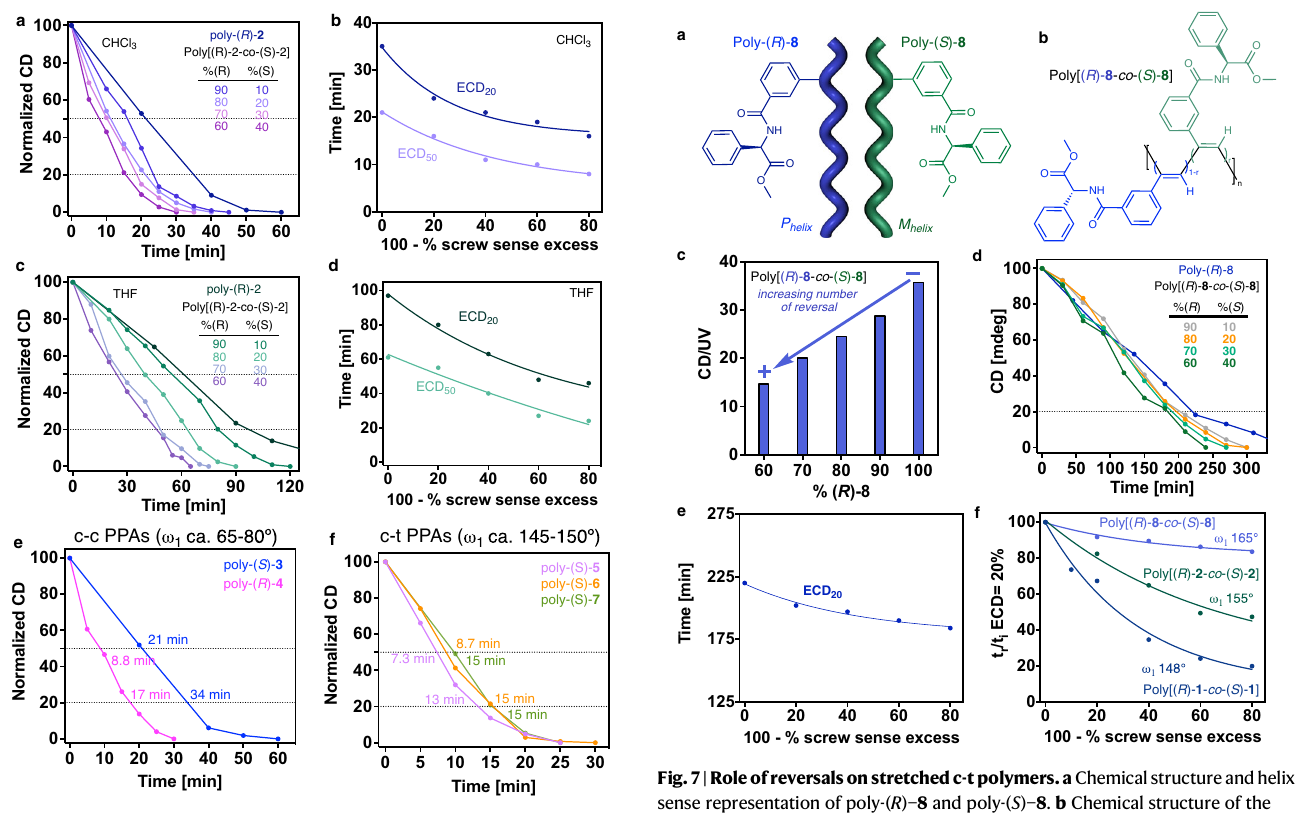
Fig.6|Studiesatdifferentirradiationtimesundervisiblelight.a,c Normalized CD signal decay vs. time for poly[( R )- 1 -co-( S )- 1 ] series at different irradiation times under visible light in CHCl 3 (CD@377nm, dark blue to purple gradient color pal- ette) and THF (CD@378nm, dark green to purple gradient color palette) respec- tively. b, d Time consumed for reach ECD signal 50 % and 20 % during the photochemicalelectrocyclizationvs. % ofreversalsin the poly[( R )- 1 -co-( S )- 1 ] series in CHCl 3 (CD@377nm; light and dark blue, respectively) and THF (CD@378nm; light and dark green, respectively) respectively. [poly[( R )- 2 -co-( S )- 2 ]]= 9.00·10 -4 M. NormalizedCDsignaldecayvs.timeatdifferentirradiationtimesundervisiblelight for ( e ) poly-( S )- 3 (CD@386nm, blue line) and poly-( R )- 4 (CD@383nm, pink line) and( f )poly-( S )- 5 (CD@368nm,pinkline),poly-( S )- 6 (CD@367nm,orangeline)and poly-( S )- 7 (CD@368nm, green line). [poly-( S )- 3 ]= 1.19·10 -3 M, [poly-( R )- 4 ]= 1.13·10 -3 M, [poly-( S )- 5 ]= 1.30·10 -3 M, [poly-( S )- 6 ]= 1.16·10 -3 M, [poly-( S )- 7 ]= 9.76·10 -4 M.